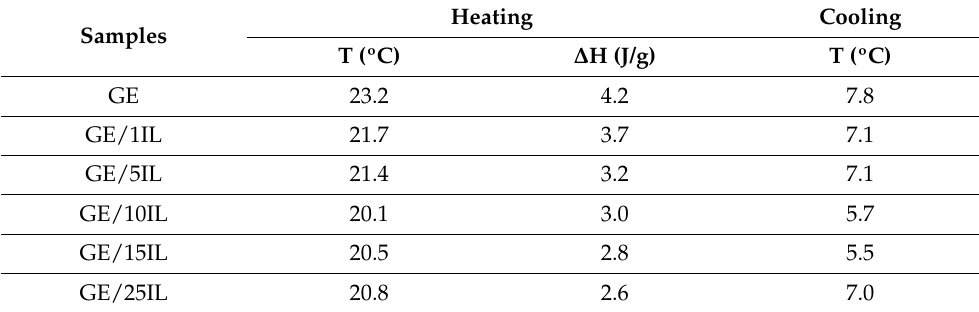
Table 7. Temperature and enthalpy associated with gelatin unfolding *.